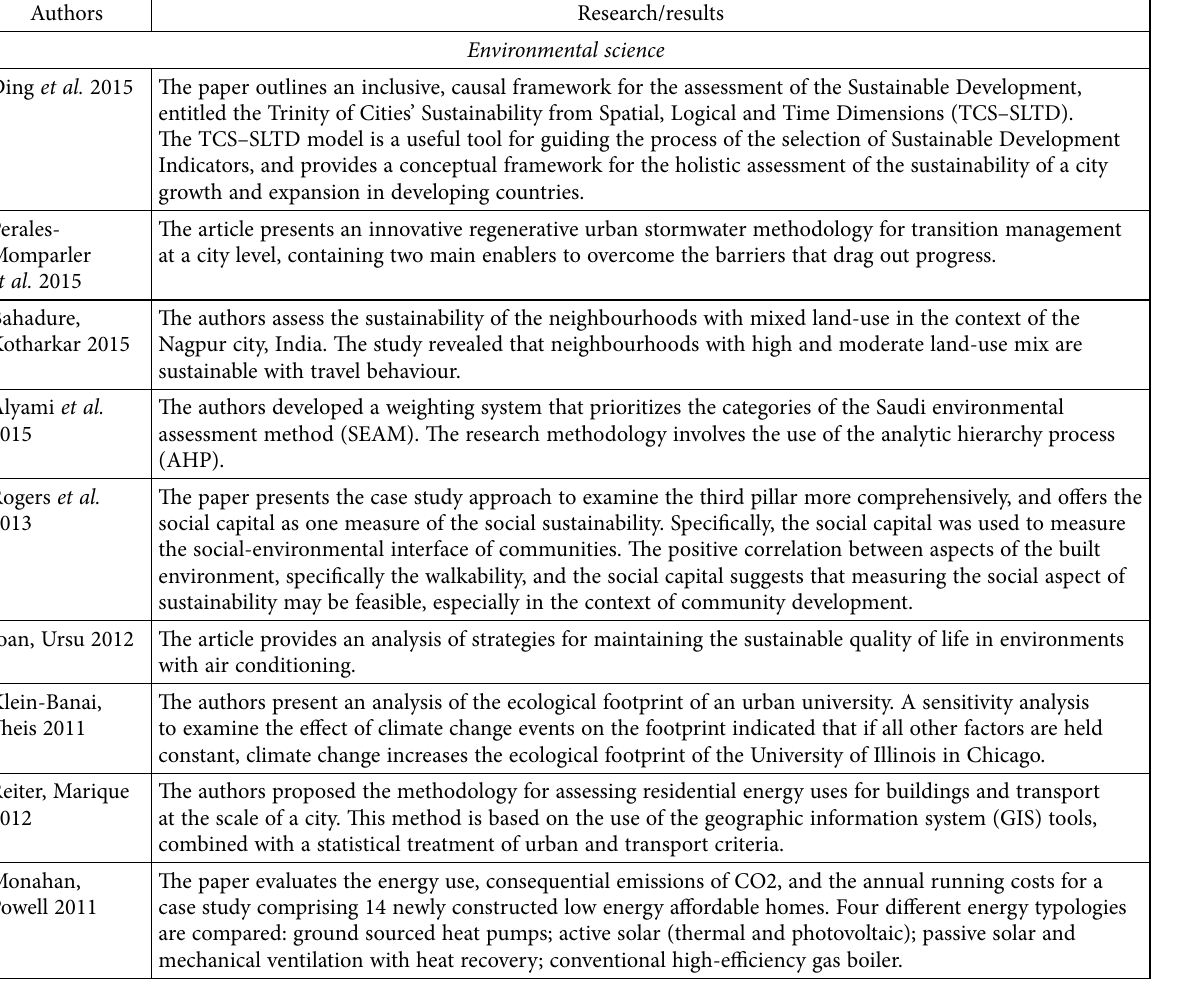
Table 2. Summary of research on the sustainable built environment in three Web of Science categories: environmental